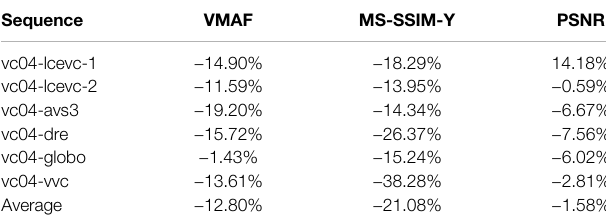
TABLE 11 | BD-rate savings for LCEVC-enhanced x265 over x265 (HLG). Sequence VMAF MS-SSIM-Y